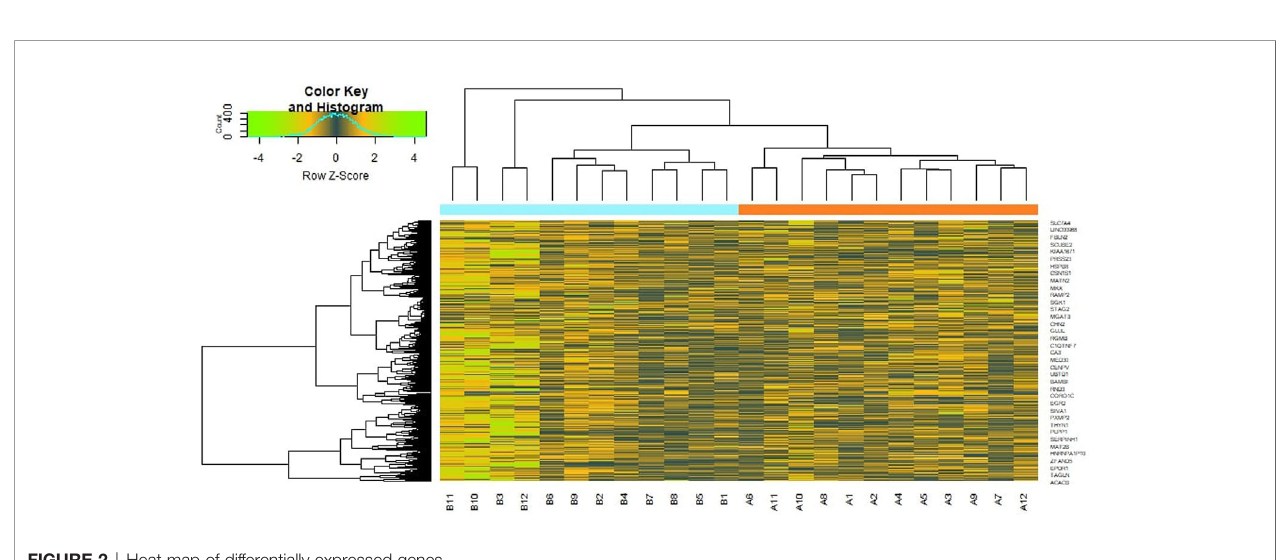
FIGURE 2 | Heat map of differentially expressed genes.